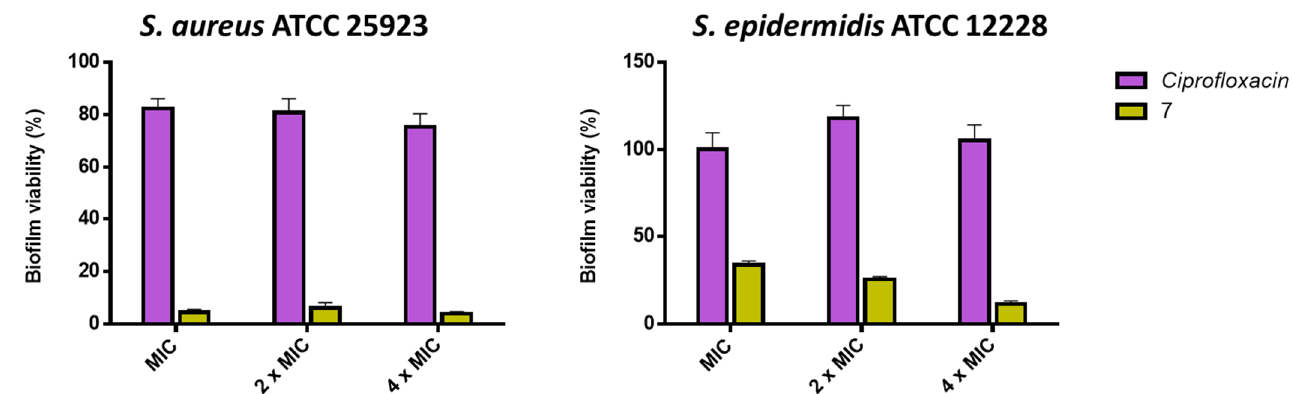
Figure 3. Activity of compound 7 and ciprofloxacin at MIC, 2 × MIC, and 4 × MIC against preformed S. aureus and S. epidermidis biofilms, after 2 h of treatment, compared to the untreated control cells, using the MTT assay. The values are the means ± SEM of the triplicates of three independent experiments.